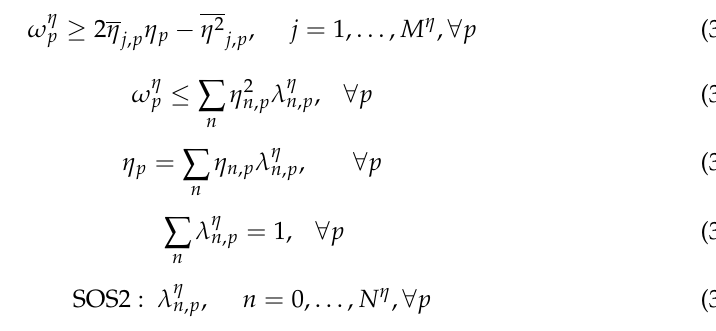
10 of 17 Table 4. Convergence indicator of the bm , de , nf5 , and nf6t relaxation schemes with partition size variation. 𝜸